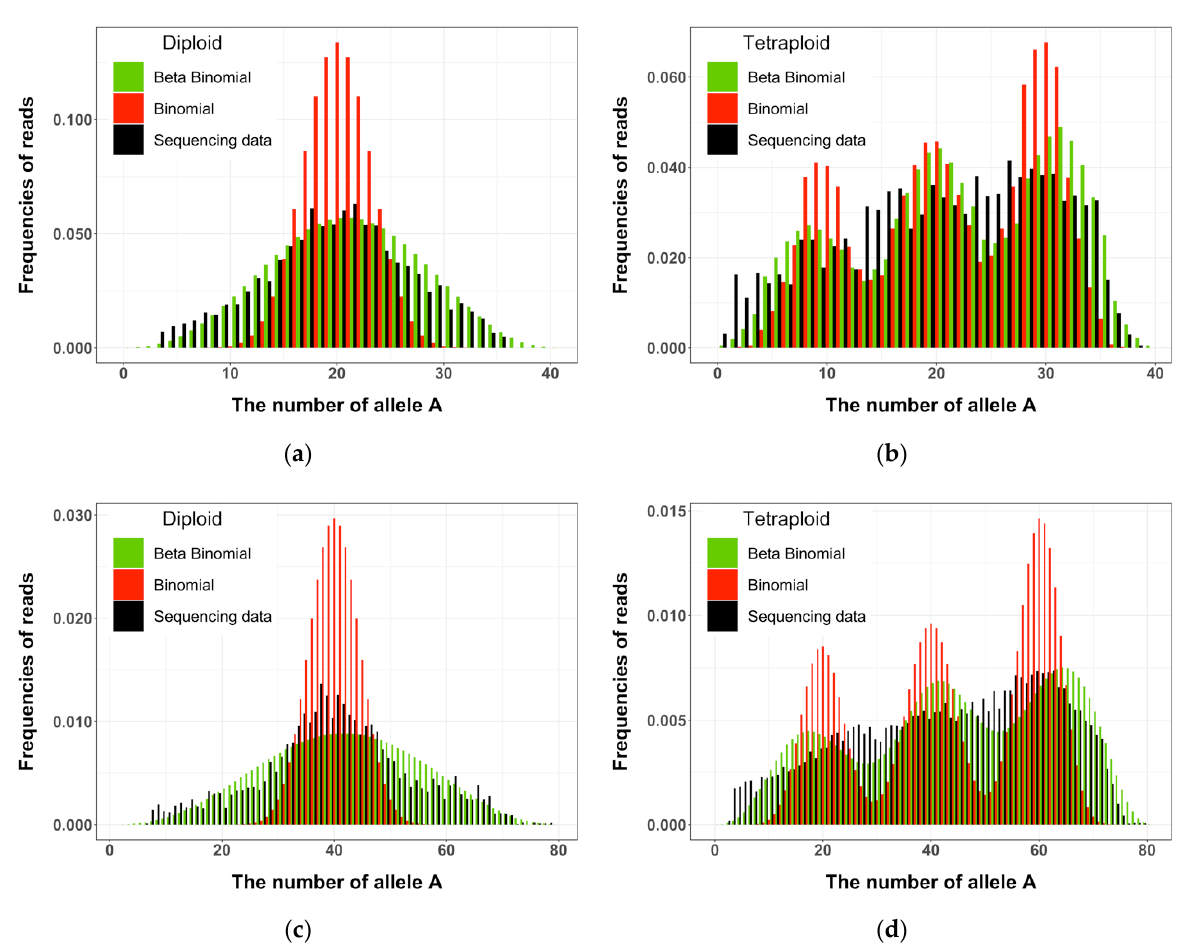
Figure 2. The histograms of the observed and expected numbers of the reference allele from the sequencing data of diploid and tetraploid potato at the coverage of 20–60 ( a , b ) or 60–100 ( c , d ). The expected values were calculated from binomial and β -binomial distributions.